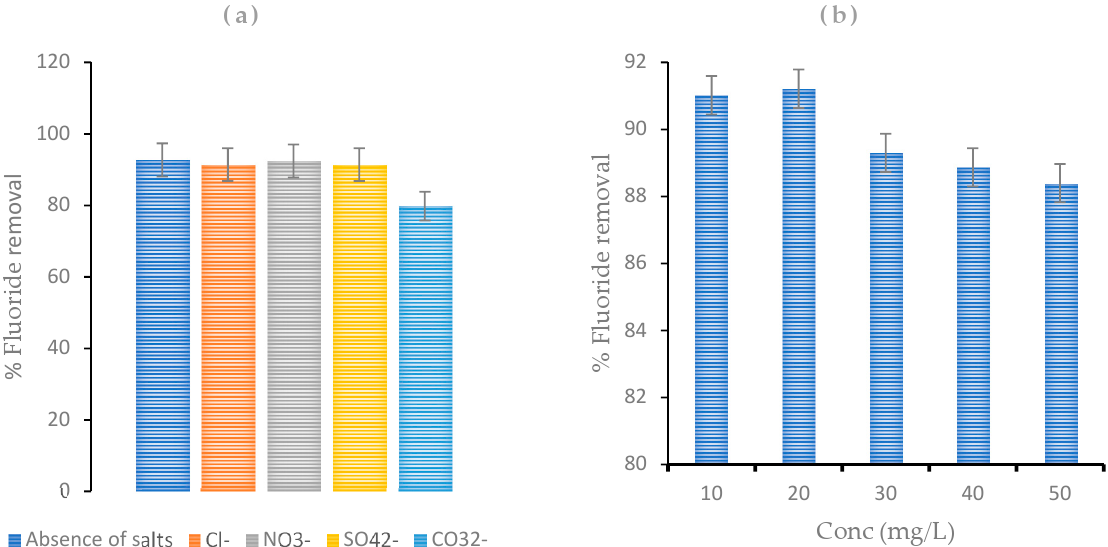
Figure 9. Effect of ( a ) co anions (0.25 g at 10 mg/L of fluoride ion with 100 mg/L of the respective individual coexisting anion); ( b ) co anion composite concentration on fluoride sorption by CNF- AgMgOnHaP composite (adsorbent dose: 0.25 g, 10 mg/L, contact time 10 min at 250 rpm).